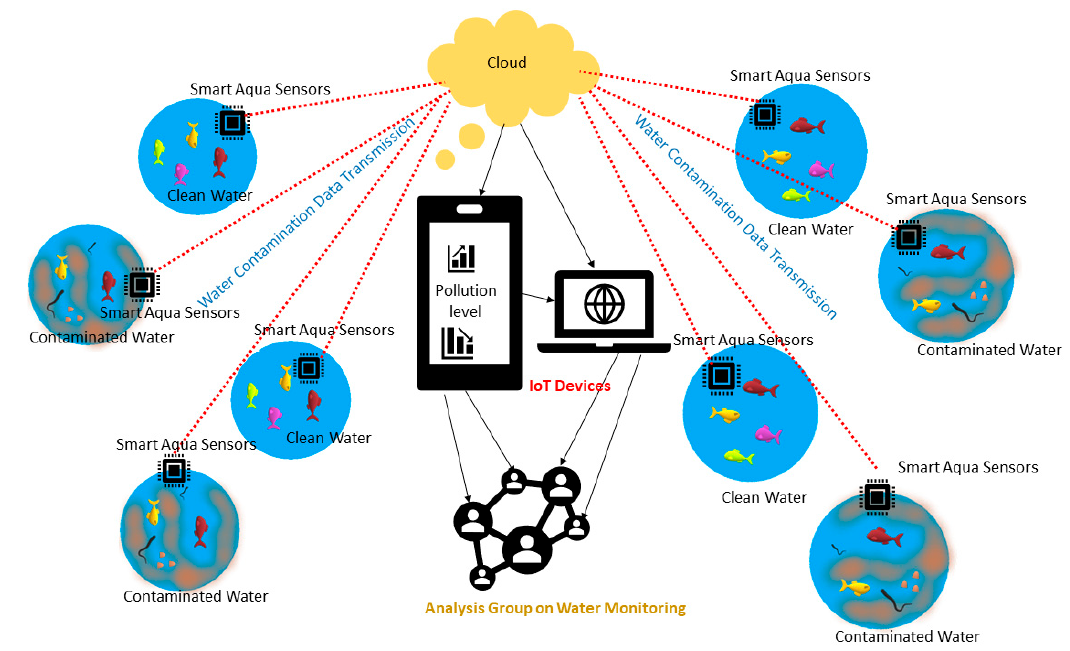
Figure 1. Smart environment monitoring (SEM) system highlighting water contamination and its monitoring using the cloud connecting internet of things (IoTs) and sensors.